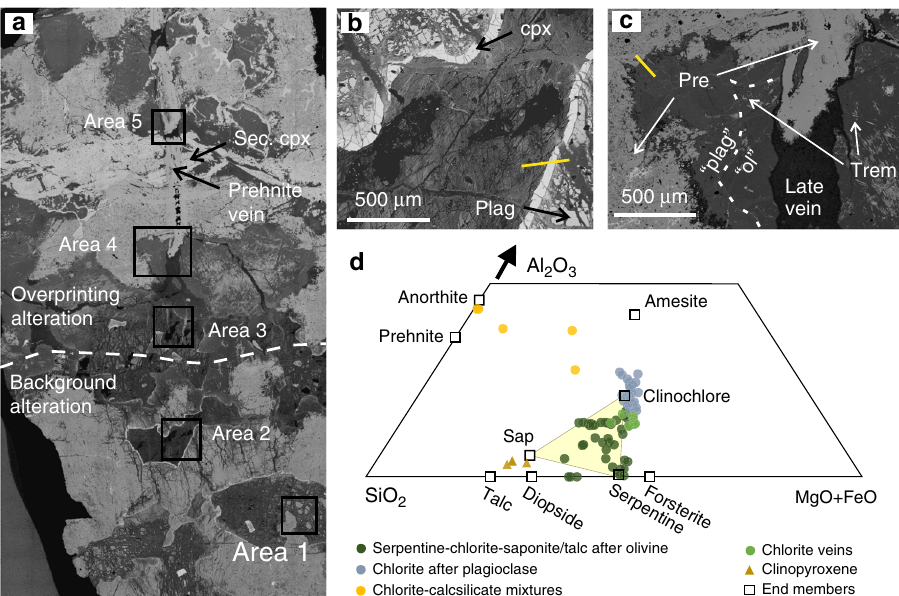
Fig. 2 Textures and electron microprobe data. a Backscatter SEM montage of slide 65984 (U1415P 23R1 85 – 90, see Fig. 1a) showing the contact between background (AM15) and overprinting (AM16) alteration, and secondary clinopyroxene (cpx) veins cut by late composite veins of prehnite and mixed phyllosilicates. b Area 2 shows relict igneous texture, with unaltered clinopyroxene rims separating plagioclase partially altered to chlorite from olivine completely altered to phyllosilicates. Yellow line indicates probe traverse (see Supplementary Data 1 for analyses). c Area 4: Igneous minerals are completely replaced apart from minor clinopyroxene. Areas of former olivine are inferred from the presence of tremolite needles formed in an earlier, higher temperature corona reaction between olivine and plagioclase 36,83 . Prehnite (pre) is present both as a complete replacement of plagioclase, and in late veins. d Phyllosilicate EPMA data, calculated assuming all Fe is FeO (Supplementary Data 1). Background replacement of olivine in areas 1 and 2 is a variable mixture of chlorite, serpentine and saponite, with some talc. Serpentine disappears almost completely in the overprinting alteration, with the typical mesh texture veins no longer visible. Background replacement of plagioclase is mainly prehnite and other calcsilicates, and this intensi fi es in the overprinting alteration, where aluminous chlorite or amesite-rich mixtures also replace plagioclase. Veins are mainly chlorite where they cut former olivine or prehnite where they cut former plagioclase. For additional SEM photographs and analysis locations, see Supplementary Fig.